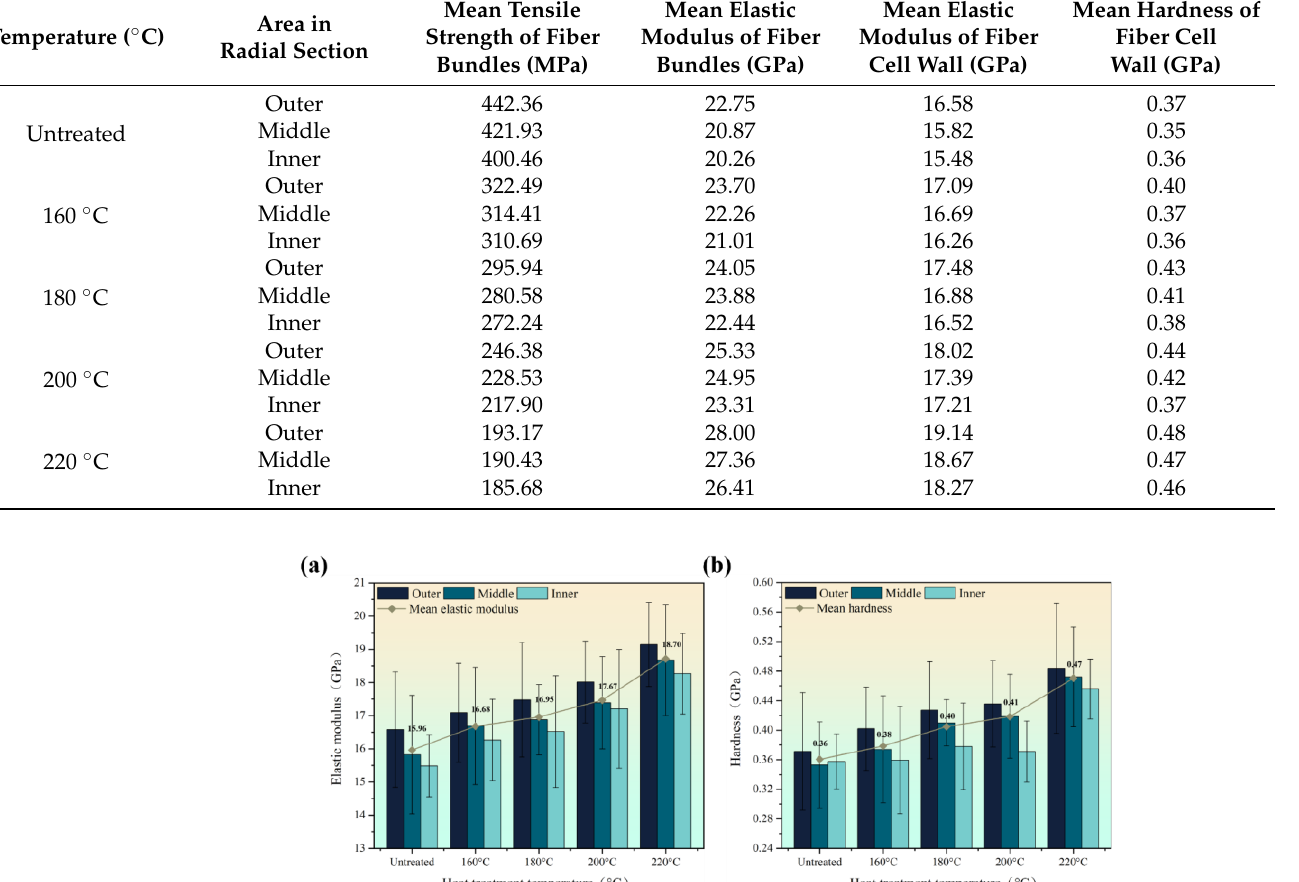
Figure 4. The micromechanical properties of the fiber cell walls in different areas in the radial direction: ( a ) elastic modulus and ( b ) hardness.